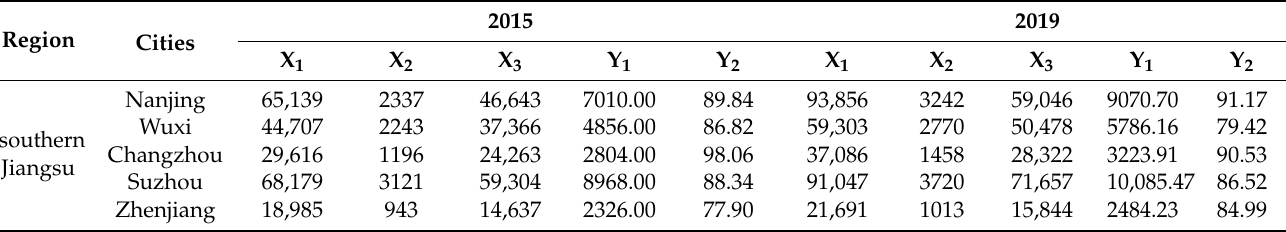
Table 3. Medical and health input-output of 13 cities in Jiangsu